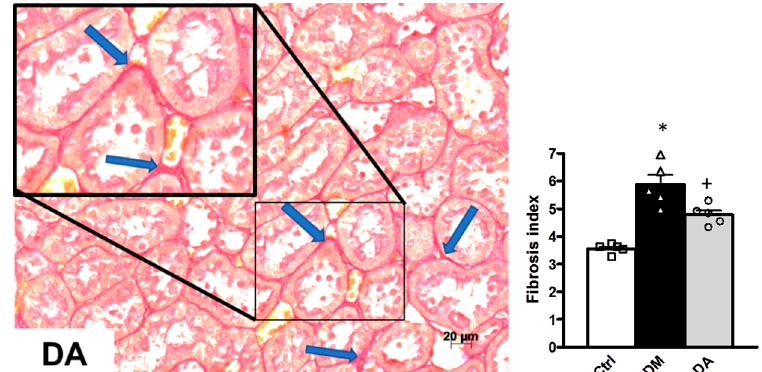
Figure 5. Interstitial fibrosis and quantitative analysis of rat kidneys. Sirius Red for collagen staining (fibrosis) in red of kidney cortex sections, representative of each experimental group. Control (Ctrl) shows very thin red lines (arrows) separating the cortex tubules in a normal interstitium. Diabetes (DM) depicts a clear modest widening of the interstitium (arrows) in comparison with the control. Diabetes + Allicin (DA) photomicrograph allows the visualization of a near normal interstitium, with a few areas of a thicker space between tubules (arrows). Original magnification 200×. Graph shows quantitative analysis of interstitial fibrosis. Values are expressed as mean ± SEM of n = 5 * p < 0.001 vs. Ctrl; + p < 0.001 vs. DM.